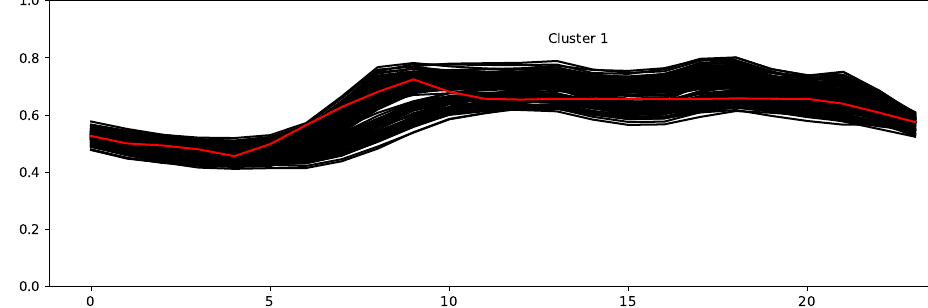
Figure A2. Season 2 demand data clustering.